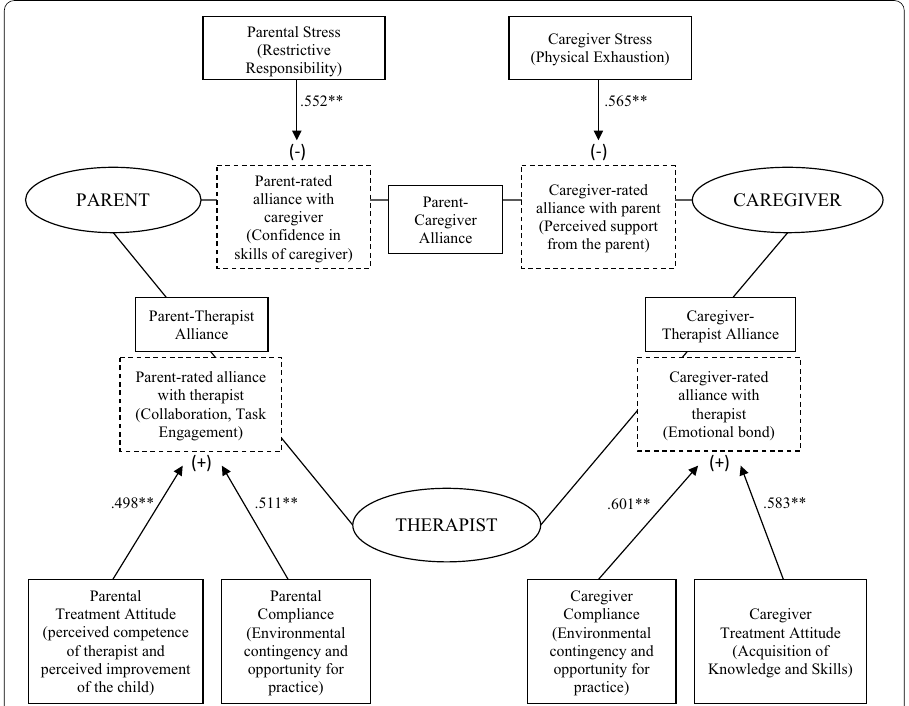
Fig. 2 Conceptual framework of the secondary system of therapeutic alliance. **Correlation is significant at 0.01